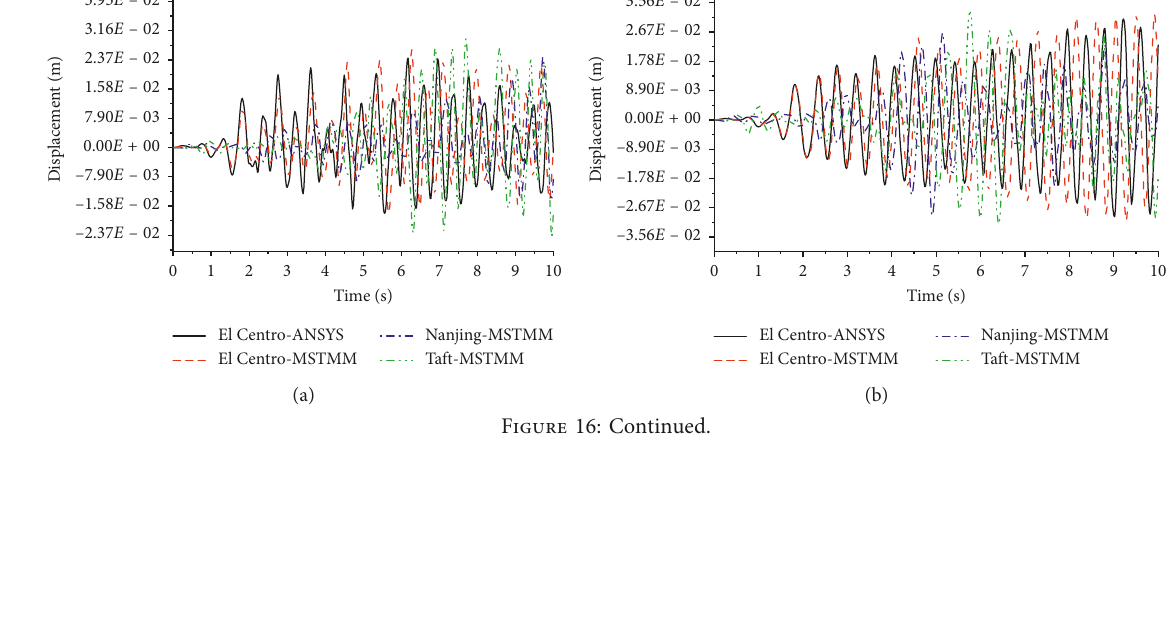
Figure 15: Time-history diagram of J 30mm.